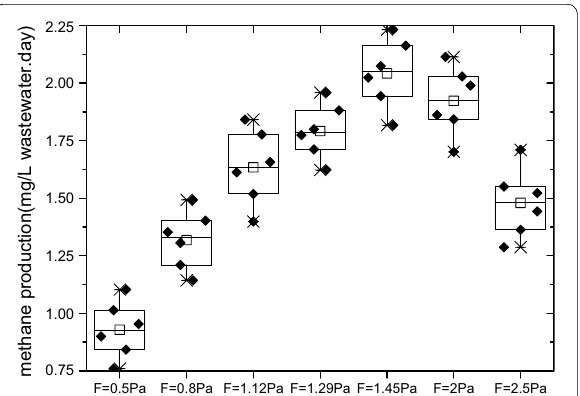
Fig. 6 Methane production at different wall-shear stresses, COD 400 mg/L. The methane production was shown. At = seven wall-shear stresses, the average methane production were 0.93, 1.32, 1.63, 1.80, 2.04, 1.93 and 1.48 mg/(L wastewater day), respec- tively. Methane production increased with the increase of wall-shear stress until the wall-shear stress reached 1.45 Pa. The maximum meth- ane production was 2.04 mg/(L wastewater day) and the minimum methane production was 0.93 mg/(L wastewater